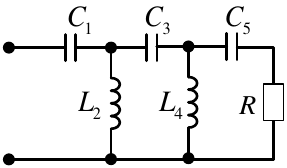
Figure 10. Single-loaded ladder